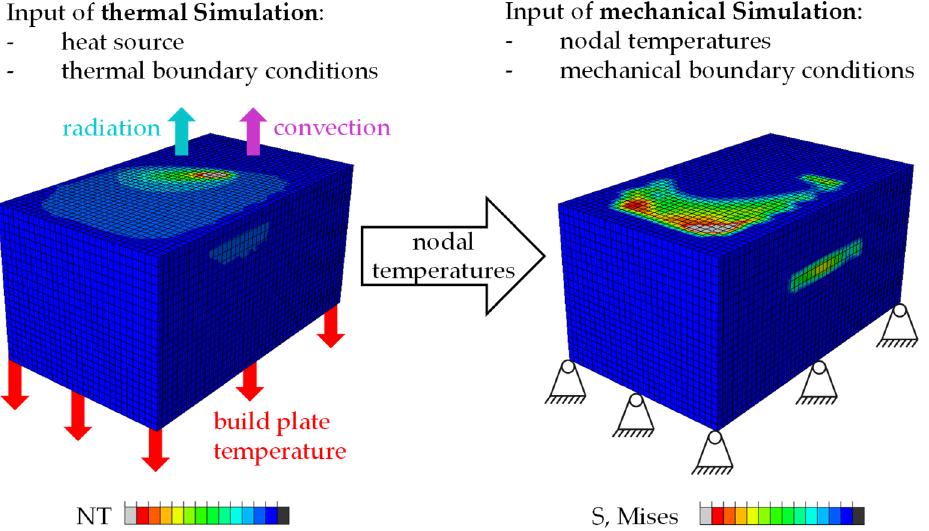
Figure 2. Approach used: weakly-coupled thermomechanical simulation with boundary conditions.